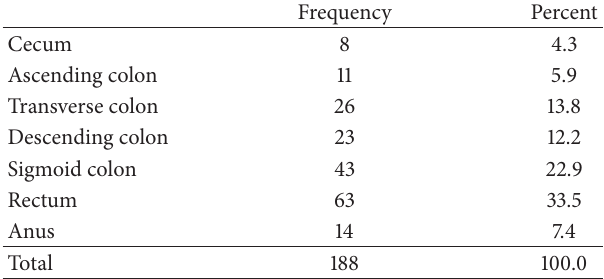
Table 1: Location of polyps (all polyps